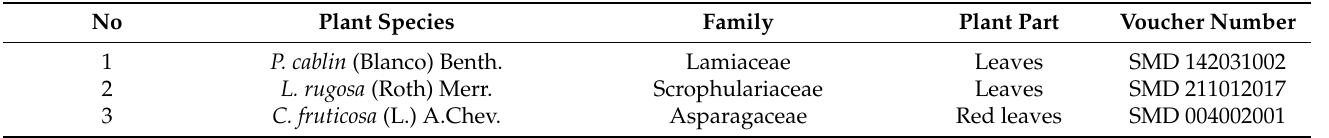
Table 1. List of plant materials and parts used in the Kheaw Hom remedy. Plant